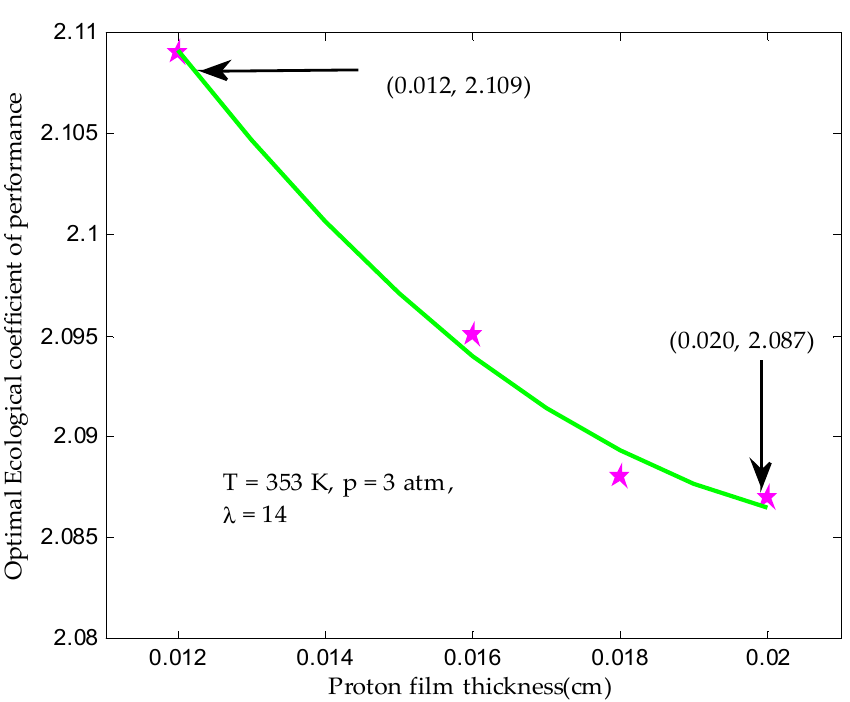
Figure 17. Optimal ECOP varying with membrane thickness.